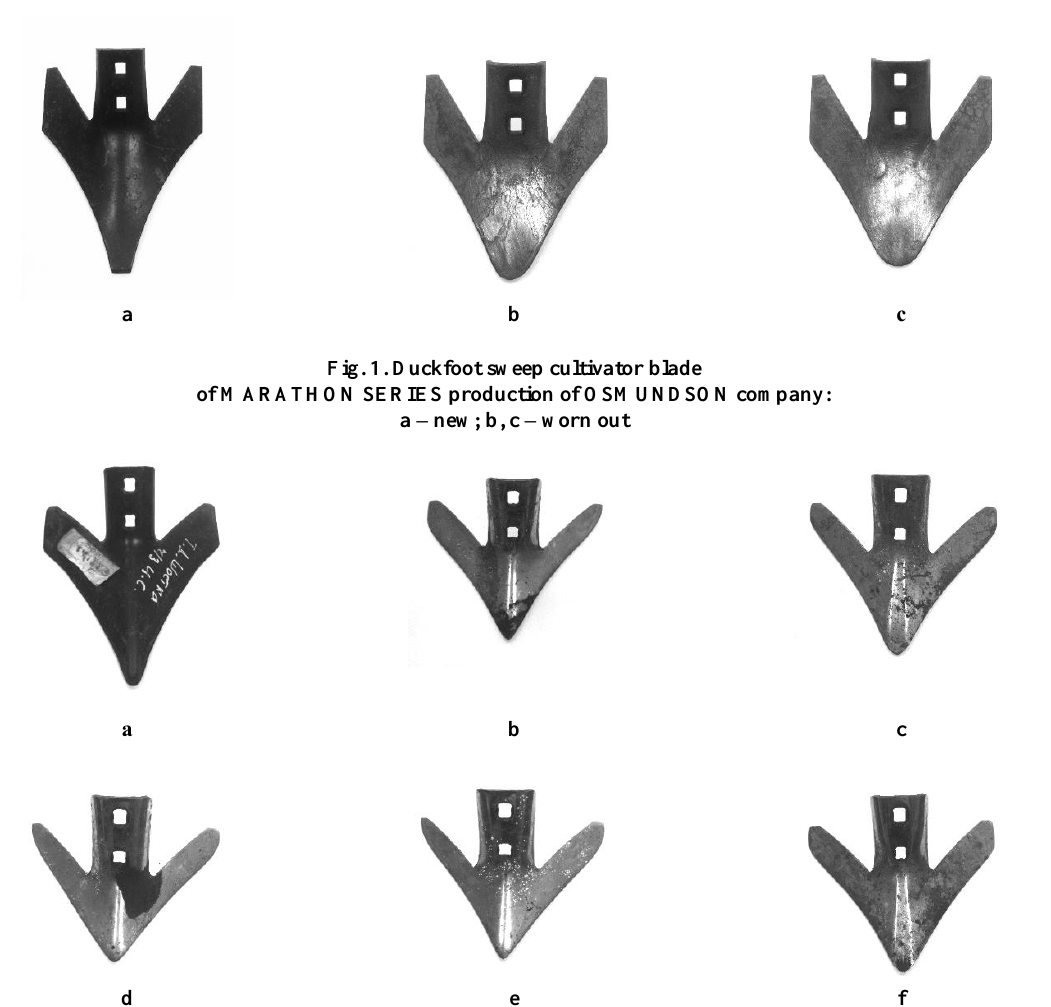
Fig. 1. Duckfoot sweep cultivator blade of MARATHON SERIES production of OSMUNDSON company: a – new; b, c – worn